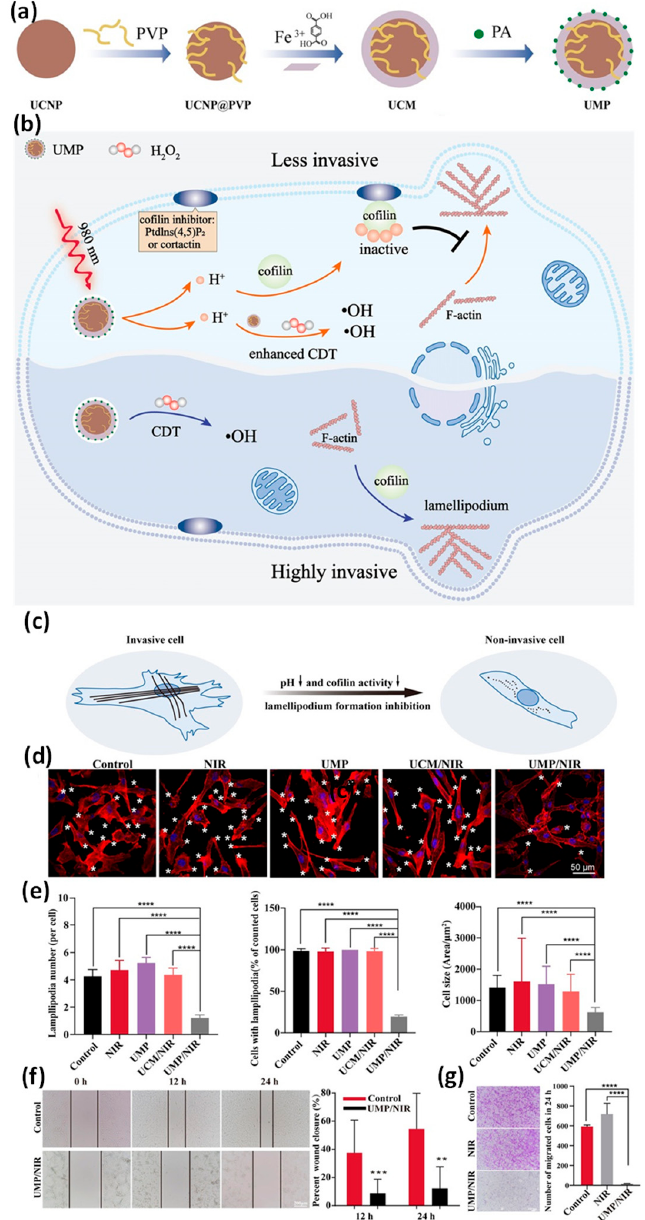
Figure 14. ( a ) Schematic illustration for the synthesis process of UCNP@MIL–88B@PA (UMP) nanoparticles. ( b ) Schematic illustration of tumor metastasis inhibition. ( c ) Schematic illustration of cell morphological changes. ( d ) Immunofluorescence of F–actin and changes in lamellipodia under different conditions. ( e ) Statistical results of the number of lamellipodia of U87MG cells, the number and size changes of lamellipodia. ( f , g ) Wound–healing and transwell invasion experiments of U87MG cells. Statistical analysis was based on Student’s t test: ** p < 0.01, *** p < 0.001, **** p < 0.0001. Reproduced from Ref. [153] with permission from Wiley–VCH, copyright 2021.